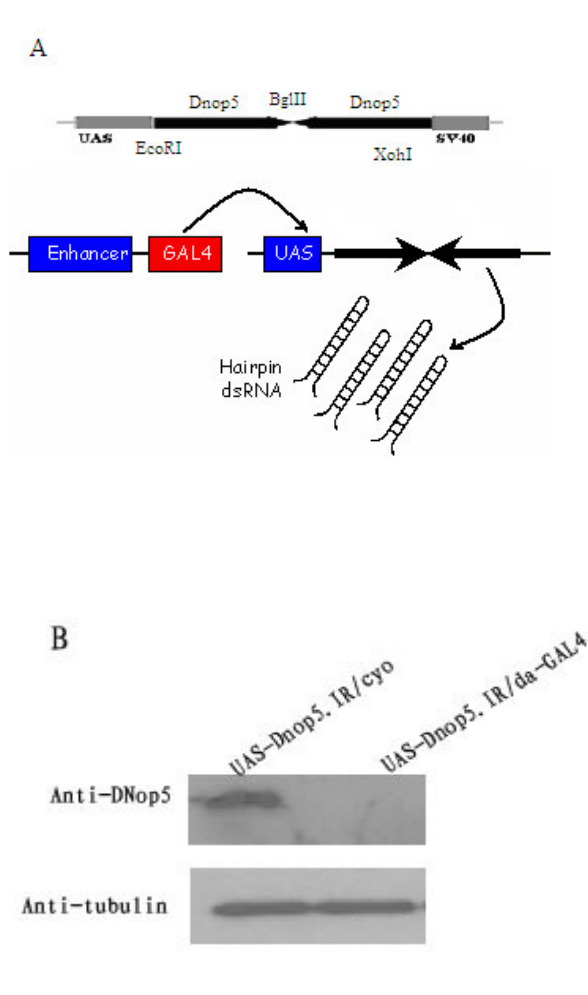
Figure 2. Inducible RNAi targets Dnop5 . (A) Strategy for inducible dsRNA synthesis.(B) Western blotting for induction of dsRNA by using the da-GAL4 driver.